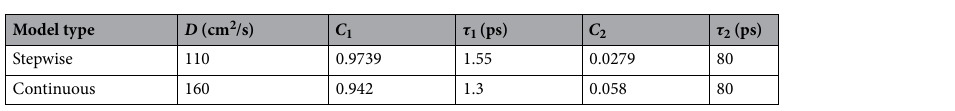
Table 1. Device parameters used in the theoretical computation for the MOCVD device in Fig. 6a.